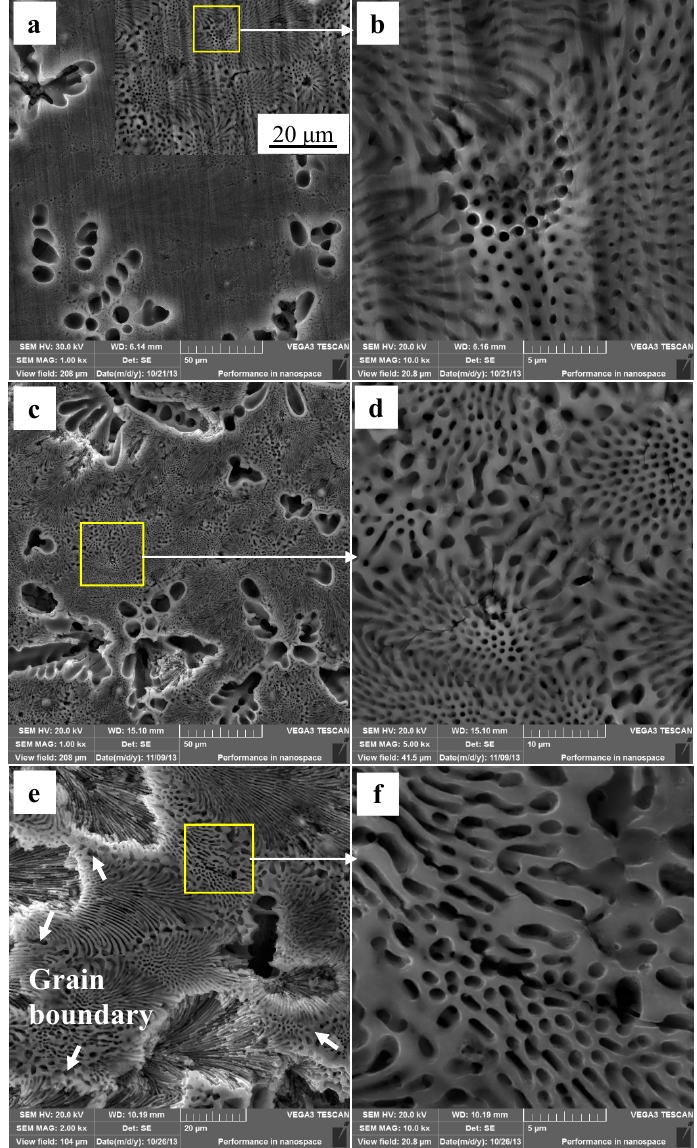
Figure 7. The corroded Mg–Al alloyspecimen’s corrosion morphologies gained from HAc solution for different immersion times: ( a , b ) 30 min; ( c , d ) 60 min; ( e , f ) 90 min.